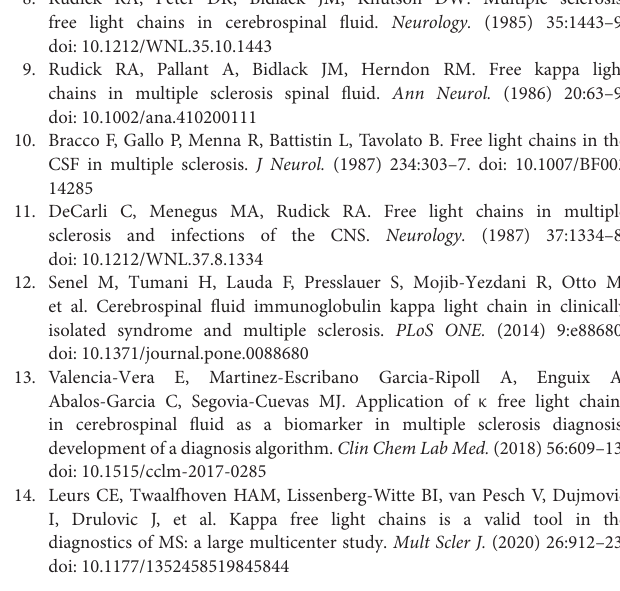
Supplementary Figure 1 | ROC curve and contingency analysis on the K-Index diagnostic performance for MS, after exclusion of cases presenting with K-FLC CSF levels below 0.03mg/dl. Supplementary Figure 2 | Mann-Whitney analysis of patients with a MS diagnosis vs. patients without MS, after exclusion of cases presenting with K-FLC CSF levels below